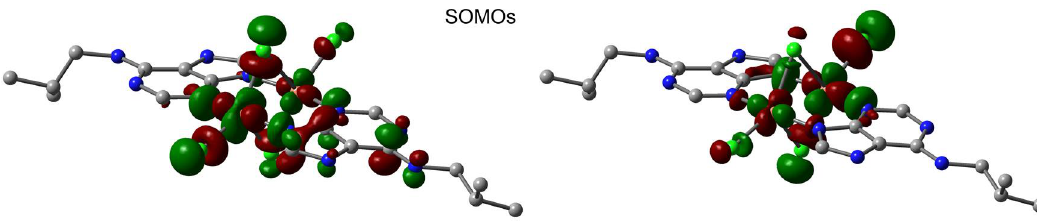
Figure 8. Graphical representation (contour 0.02 e Å − 3 ) of the single occupied molecular orbitals (SOMOs) of complex 3 .